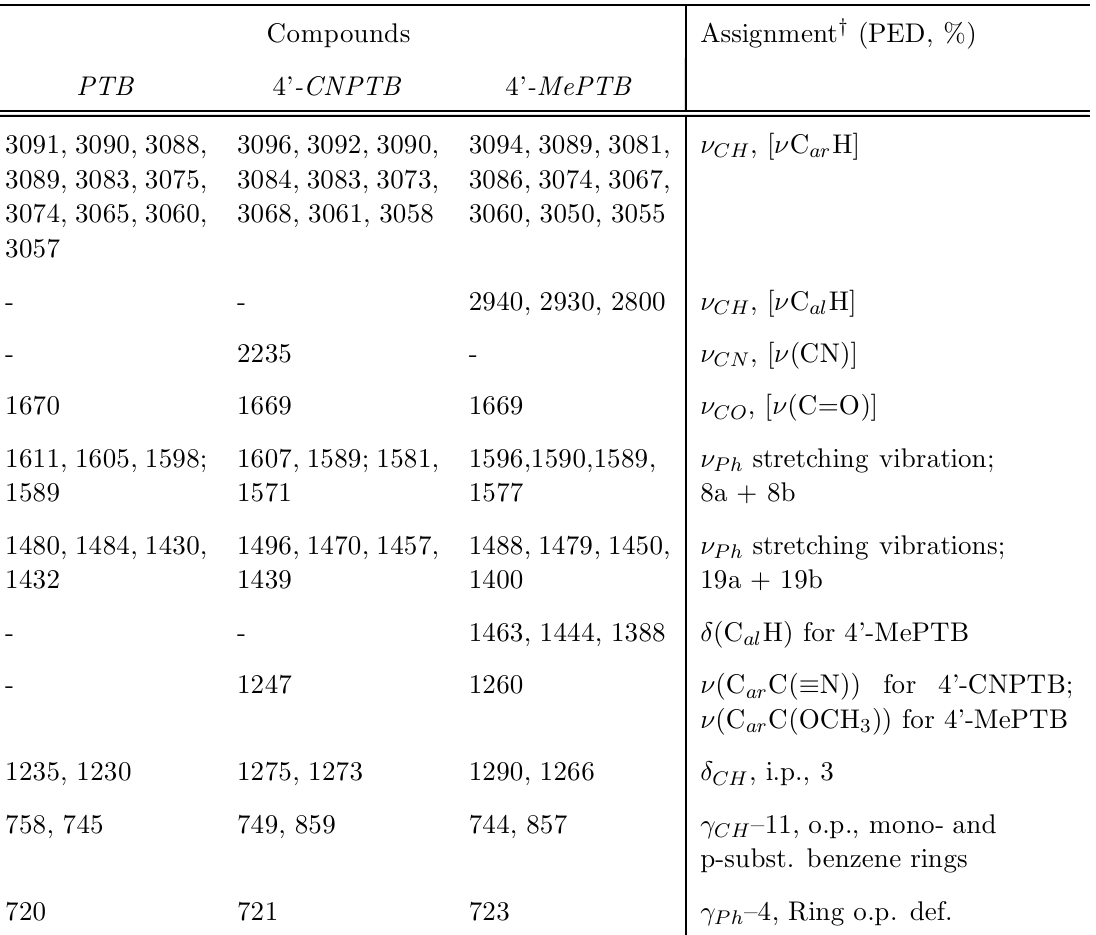
Table 2 Selected calculated frequencies for PTB, 4’-CNPTB and 4’-MePTB in cm ¡ 1 . y Only the main contributions are shown: ¸ - stretching, ¯ - bending, i.p. { in-plane, o.p. {